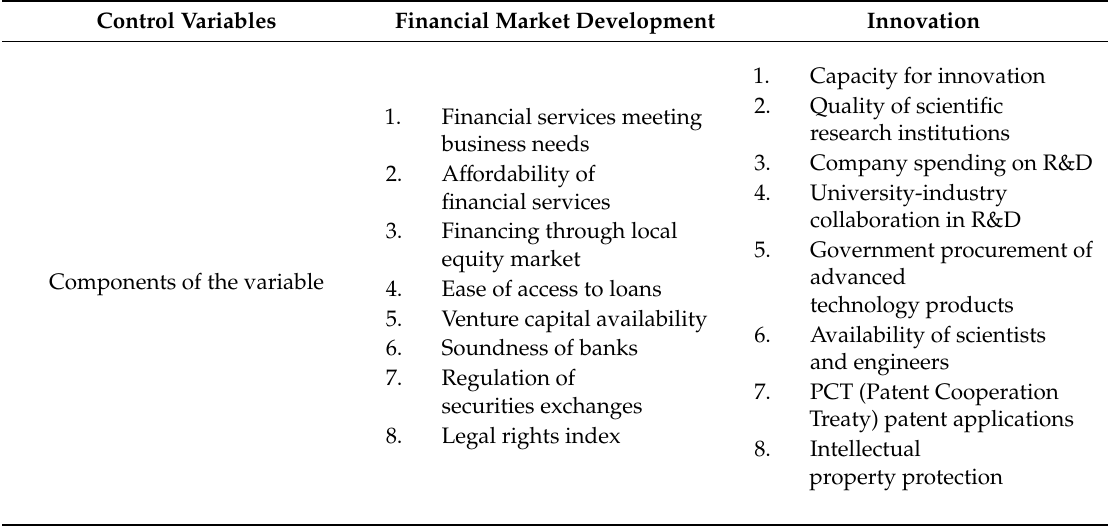
Table 4. Components of control variables 1